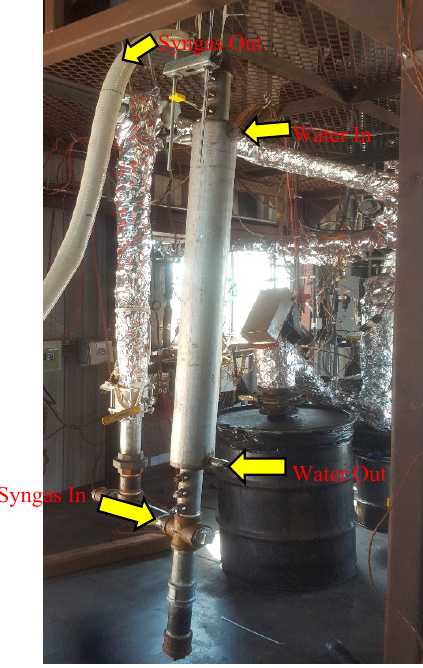
Figure 5. A single tube heat exchanger used for cooling syngas for treatment II.